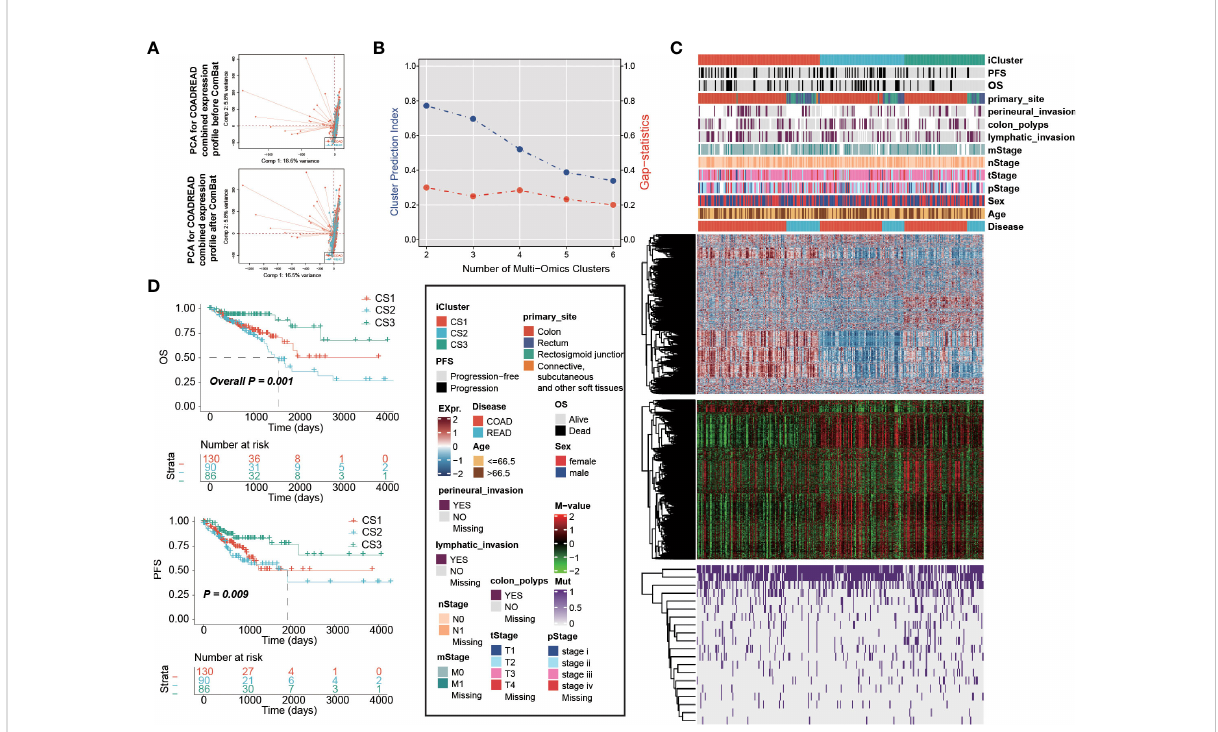
FIGURE 1 Multi-omics integrative molecular subtype of colorectal cancer. Principal component analysis to investigate the potential batch effect between TCGA-COAD and TCGA-READ. (A) before and after Combat. (B) Identi fi cation of optimal clustering number by calculating CPI and Gaps- statistics. (C) Comprehensive heatmap showing the molecular landscape of three cancer subtypes of colorectal carcinoma using integrative clustering. Kaplan-Meier curves of (D) OS and PFS with log-rank test for 306 patients with colorectal cancer according to the current molecular classi fi